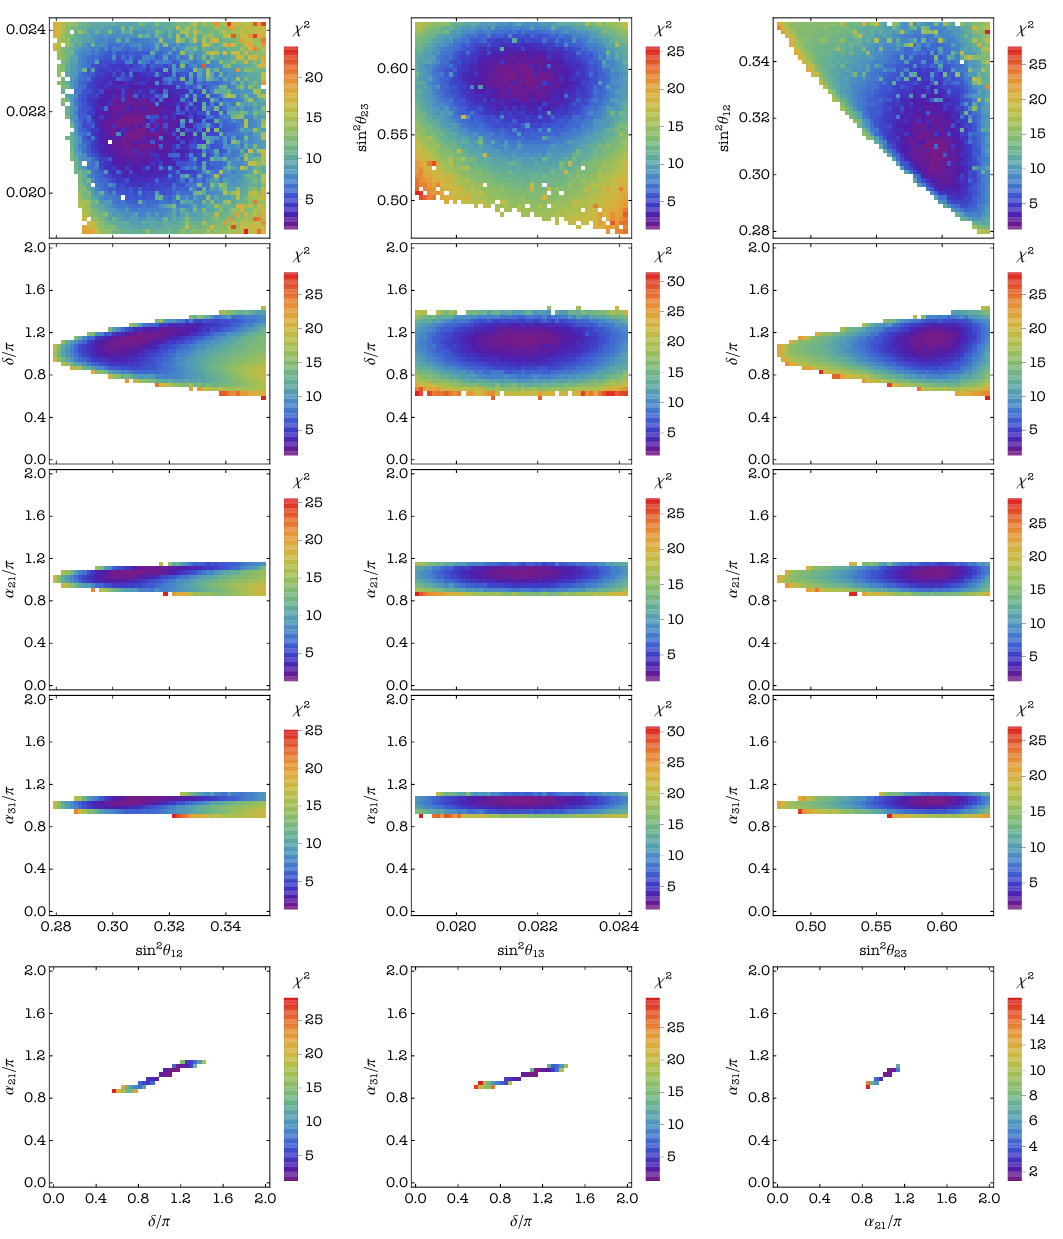
Figure 7 . Correlations between the neutrino mixing parameters in case C3. The values of all the three mixing angles are required to lie in their respective 3 (cid:27) ranges. Colour represents values of (cid:31) 2 for the IO neutrino mass spectrum.